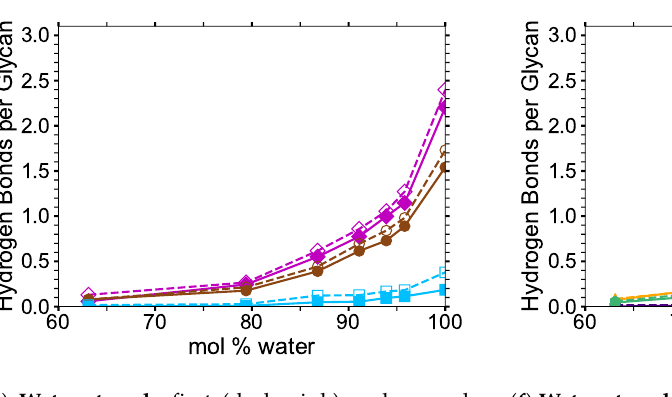
( d ) TBP-strand : center (purple), corner (orange), and the strands above the corner strands (green).